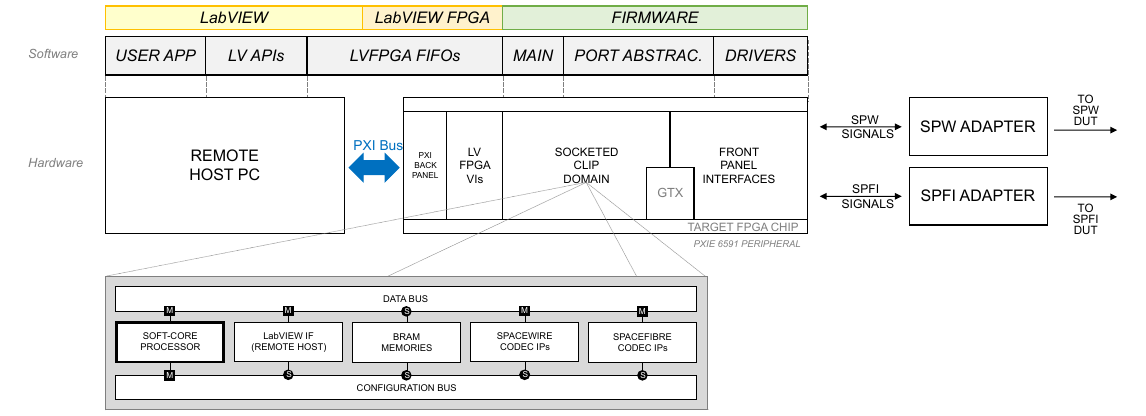
Figure 3. Block diagram of the proposed